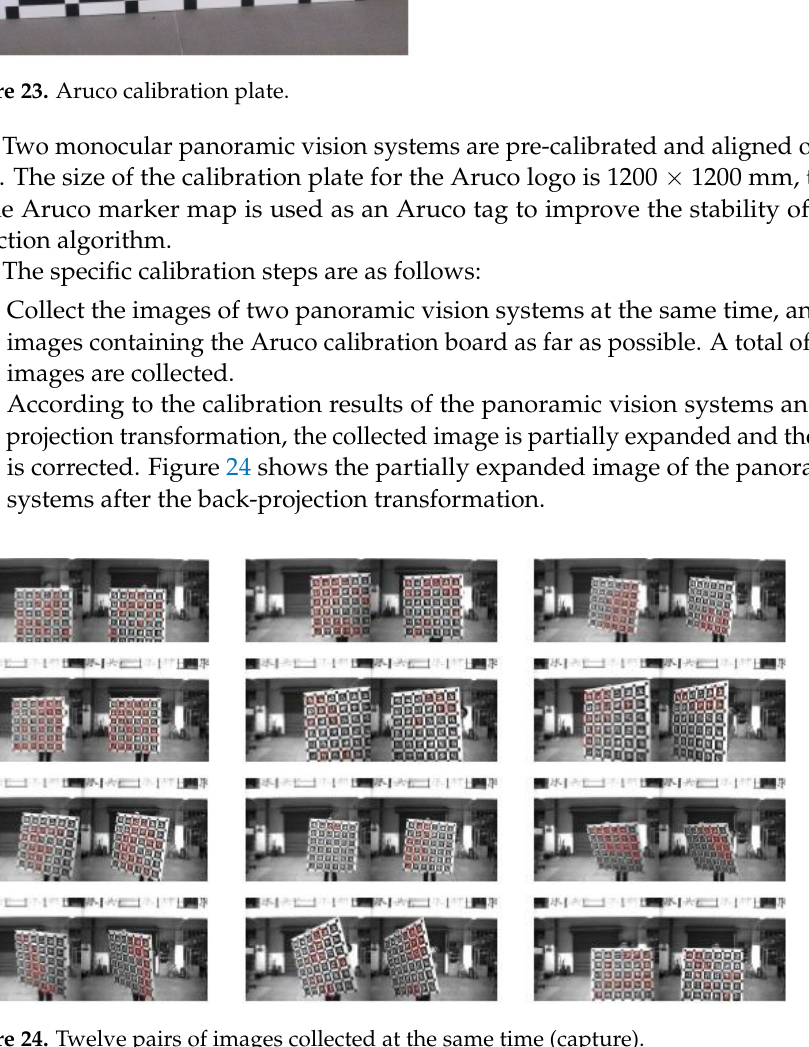
Figure 23. Aruco calibration plate. Two monocular panoramic vision systems are pre-calibrated and aligned on the same base. The size of the calibration plate for the Aruco logo is 1200 × 1200 mm, the pattern of the Aruco marker map is used as an Aruco tag to improve the stability of the Aruco detection algorithm.